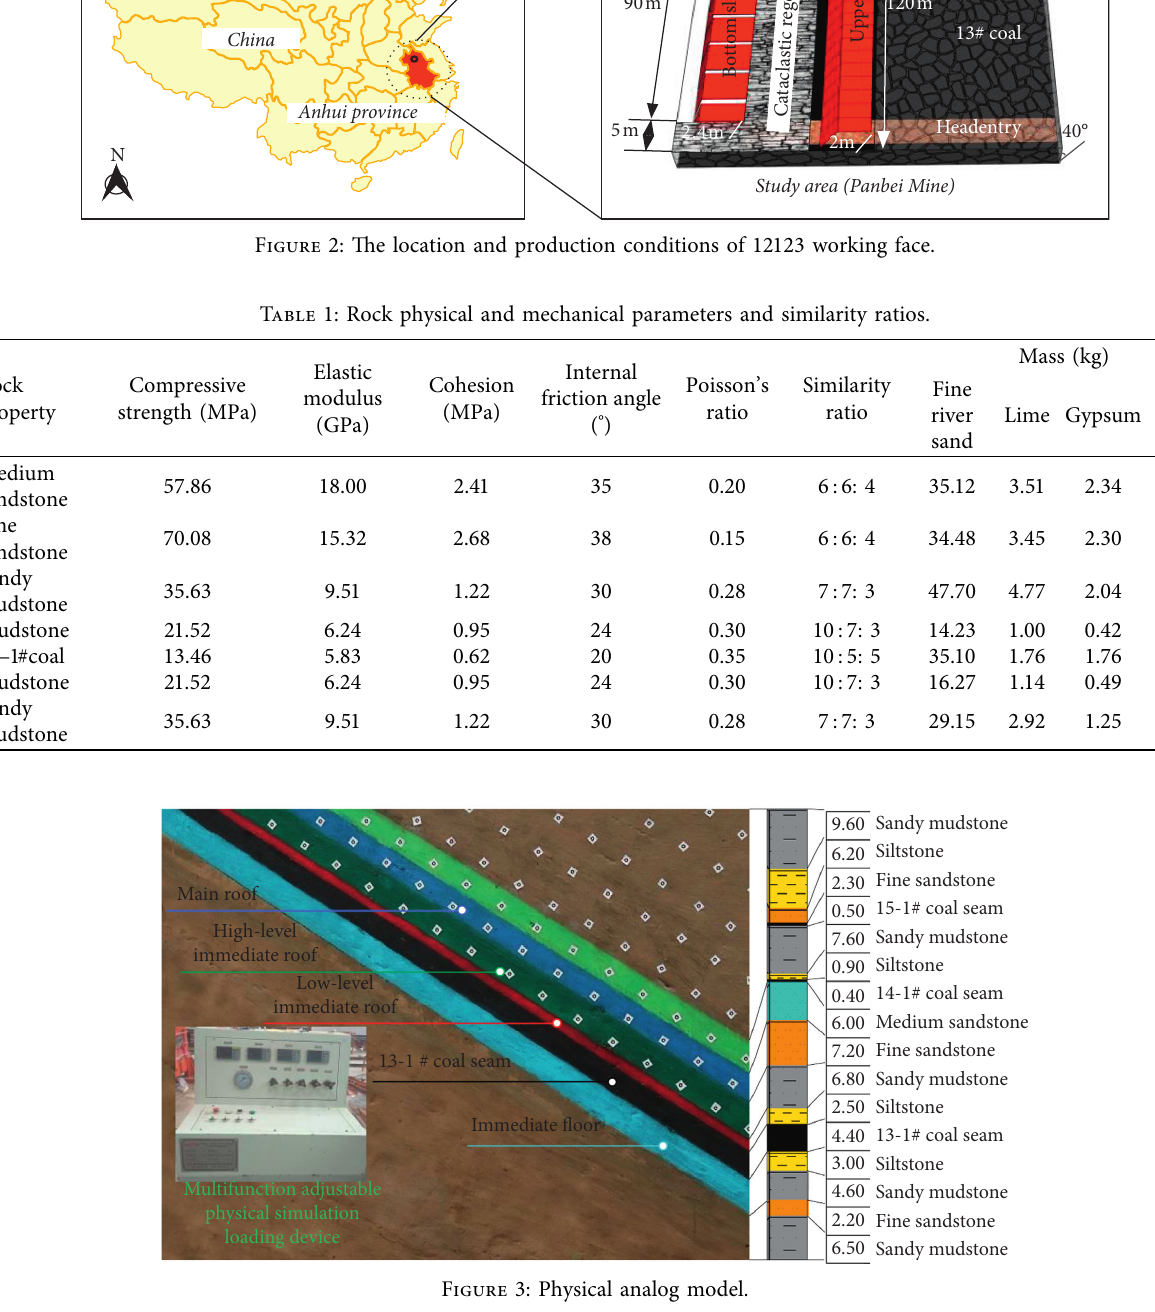
Figure 5. After the lower slice’s excavation, there is a free